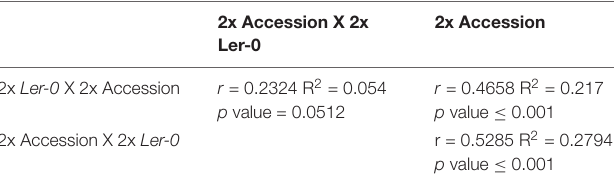
TABLE 1 | Influence of parental seed size on F1 seed size heterosis in hybrid offspring.